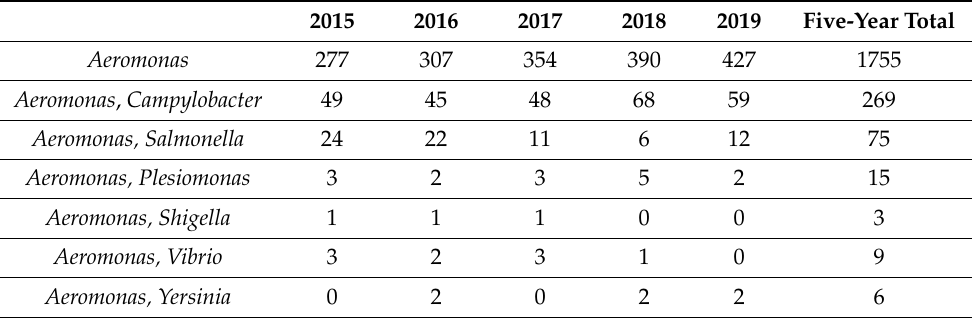
Table 2. Isolation of Aeromonas species alone or co-isolation with other enteric bacterial pathogens in years 2015–2019